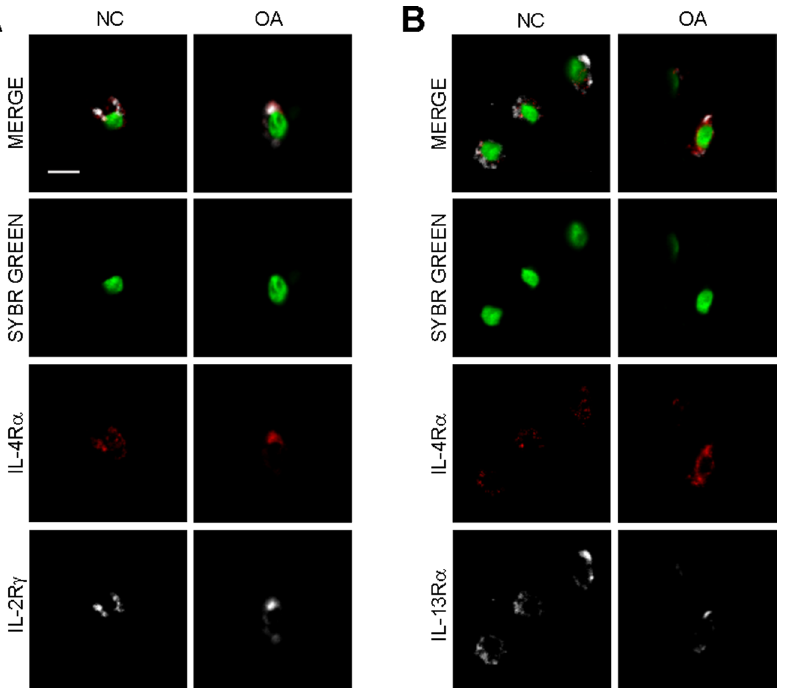
Figure 3. Co-localization of IL-4R subunits expressed in normal and OA cartilage. A : a representative example of IL-4R a and IL-2R c colocalization (IL-4 Receptor type I) in control and OA cartilage. B : a representative example of IL-4R a and IL-13R a 1 (IL-4 Receptor type II) in control and OA cartilage (bar =10 m m). Panels show IL-4R staining (Dy Light 647, rendered in red), either IL-2R c or IL-13R a (Alexa 555, rendered in white), nuclear counterstaining (sybr green, rendered in green) and merged signals.